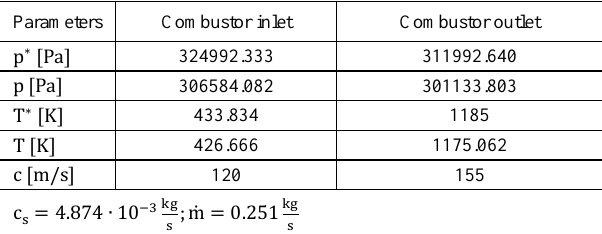
Table 1. Reference gas microturbine and combustor operating parameters